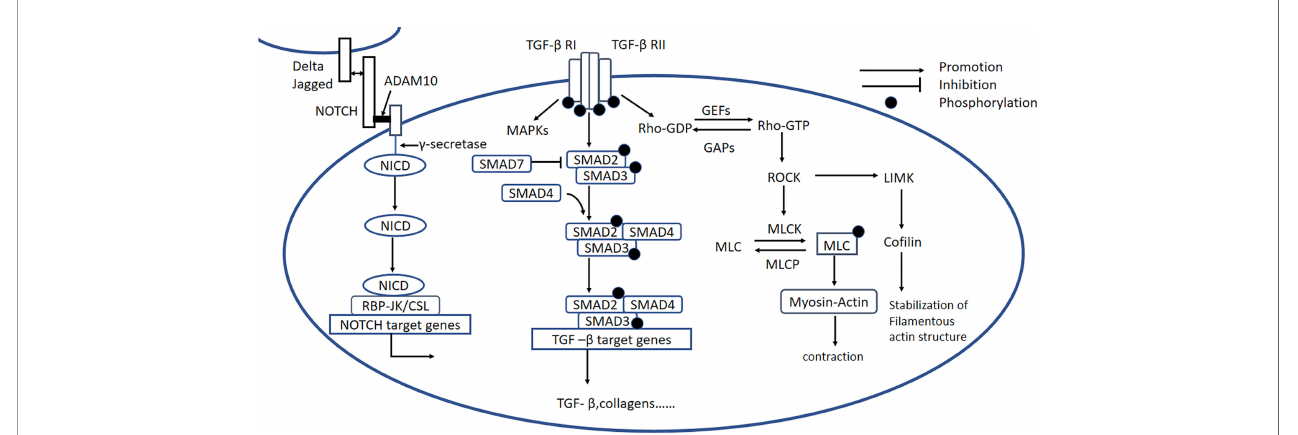
FIGURE 5 | Rho/ROCK, Notch, and TGF- b signaling pathways. Rho/ROCK signaling pathway: Rho proteins can be activated by GEFs, involving the conversion of Rho-GDP to Rho-GTP, which activates ROCK. Notch signaling pathway: Notch signaling is initiated when ligands (Delta or Jagged) on the origin cell bind to Notch receptors on the recipient cell. Membrane-situated ADAM10 clamps the Notch extracellular domain to the plasma membrane and causes the release of the extracellular Notch fragment, still bound to its ligand, which initiates intracellular signaling. The remaining part of the Notch molecule is processed by a g -secretase protease complex, which results in the release of the NICD. The NICD is then translocated to the nucleus, where it forms a Notch transcriptional activation complex with the DNA-binding protein CSL (also known as RBP-JK) and regulates Notch target gene expression. TGF- b signaling pathway: Active TGF- b binds to type II and type I receptors, activating downstream SMAD-dependent and SMAD-independent signaling pathways, including the RhoA and MAPK signaling pathways. GEFs, guanine nucleotide exchange factors; GAPs, GTPase-activating proteins; LIMK, LIM kinase; MLCK, myosin light chain kinase; p-MLC, phospho-myosin light chain; MLCP, phospho-myosin light chain phosphatase; ADAM10, metalloproteinase domain-containing protein; Delta/Jagged, Notch ligands; NICD, Notch intracellular domain; TGF- b , transforming growth factor b